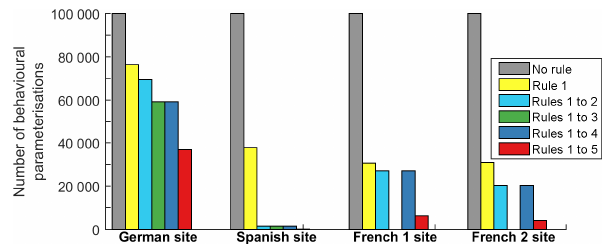
Figure 3. Reduction in the number of behavioural parameterisa- tions of the V2Karst model at the four FLUXNET sites, when se- quentially applying the five soft rules defined in Sect. 4.1 (no rule – initial sample; rule 1 – ET bias; rule 2 – ET correlation; rule 3 – soil moisture correlation; rule 4 – runoff; and rule 5 – a priori infor- mation). Rule 3 could not be applied to the French sites where soil moisture observations were not